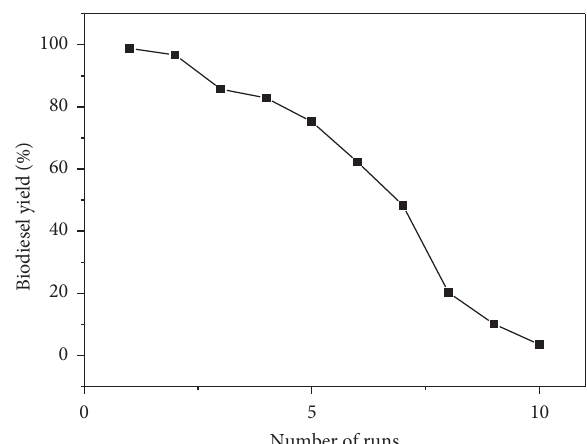
Figure 8: The recyclability catalyst versus % of biodiesel